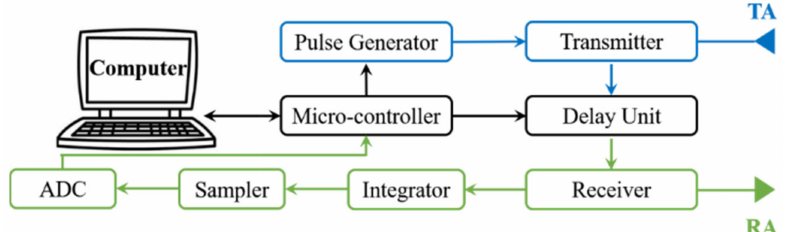
Figure 1. Diagram depicting the utilized ultrawideband (UWB) radar (TA: transmitting antenna, RA: receiving antenna, ADC: analog-to-digital converter).